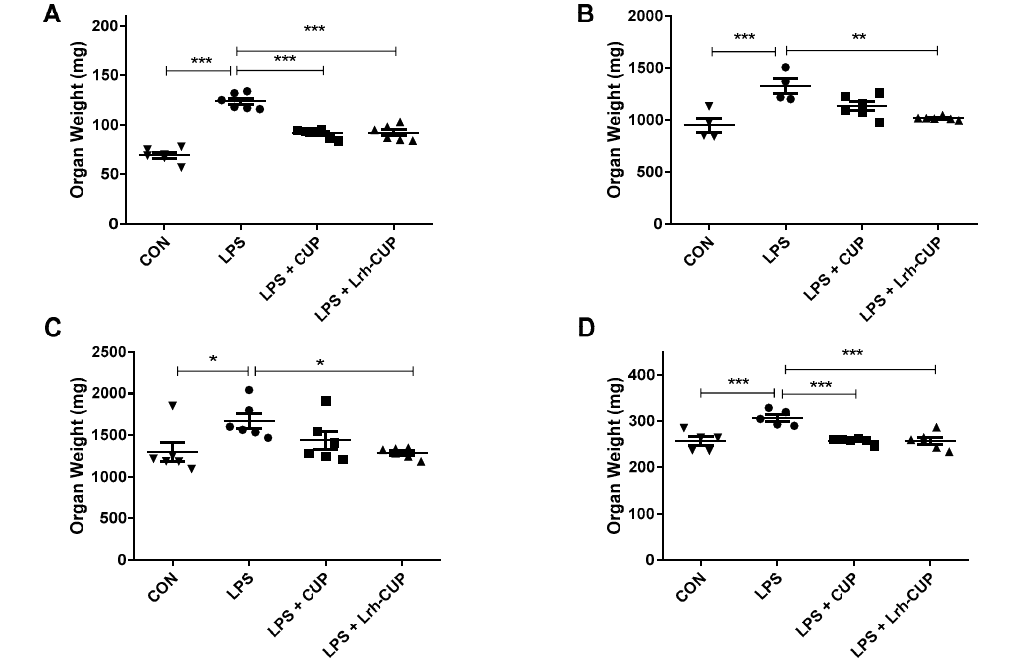
Figure 4. Effects of fermented and unfermented Theobroma grandiflorum juice on the weight of some organs of mice submitted to LPS-mediated endotoxemia. ( A ) Spleen; ( B ) Liver; ( C ) Gut; ( D ) Kidneys. * Significant differences with p < 0.05; ** Significant differences with p < 0.01; *** Significant differences with p < 0.0001. LPS: mice submitted to LPS-mediated endotoxemia; LPS + CUP: mice treated with unfermented T. grandiflorum juice and submitted to LPS-mediated endotoxemia; LPS + Lrh- CUP: mice treated with L. rhamnosus -fermented T. grandiflorum juice and submitted to LPS-mediated endotoxemia.